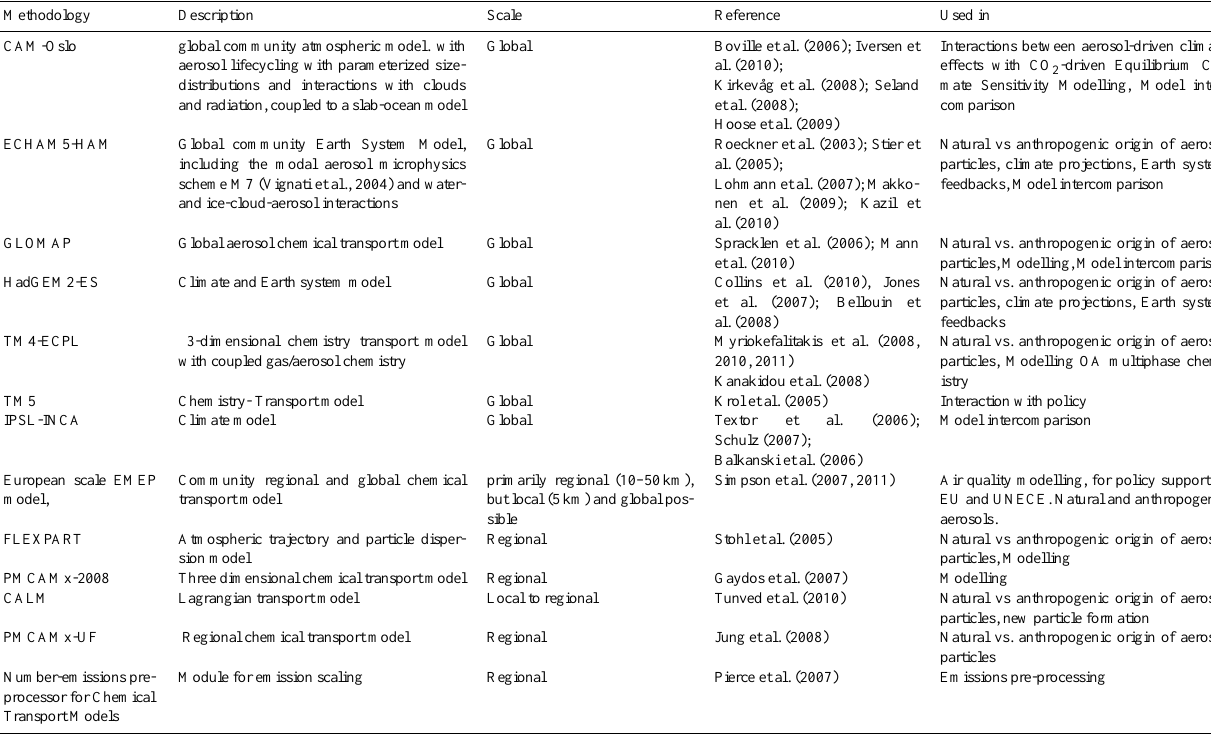
Table A5. Main computational methods used in EUCAARI (large